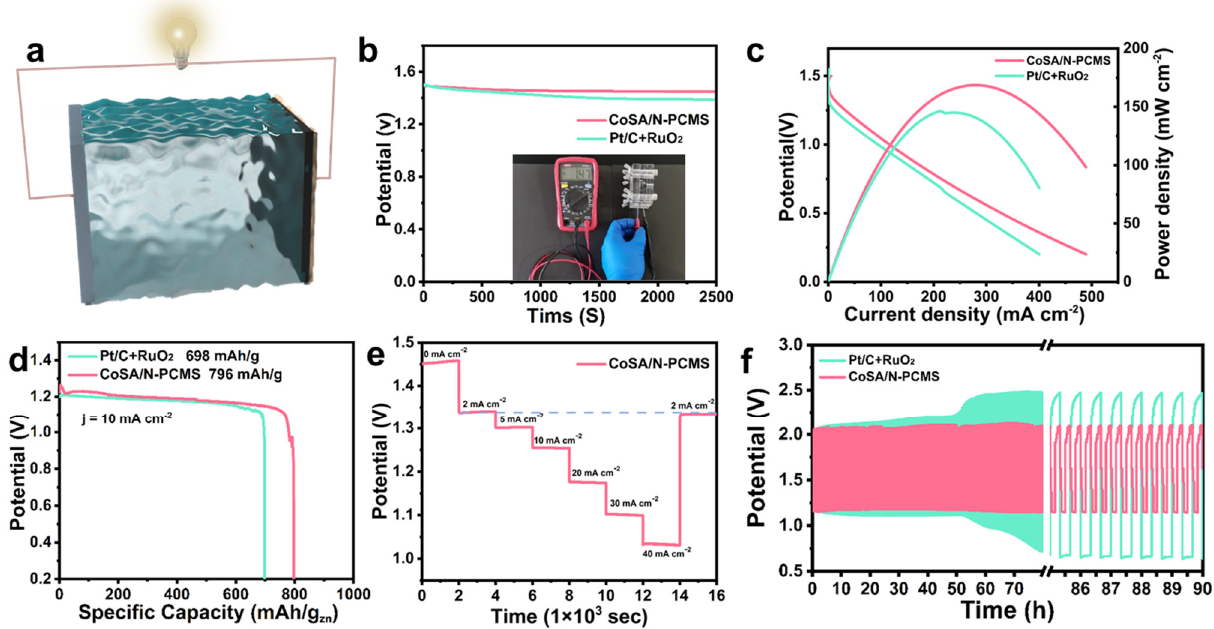
Figure 5. ( a ) Schematic diagram of the aqueous ZAB using CoSA/N − PCMS as an air cathode. ( b ) OpeN − Circuit voltage (OCV) measurements of assembled ZABs with CoSA/N − PCMS and Pt/C+RuO 2 . ( c ) The polarization and power density results for ZABs with CoSA/N − PCMS and Pt/C+RuO 2 . ( d ) The discharge curves of ZABs based on CoSA/N − PCMS and Pt/C+RuO 2 at 10 mA/cm 2 . ( e ) Discharge curves of the ZAB assembled with CoSA/N − PCMS at varied current densities. ( f ) Discharge/charge cycling performance of ZABs based on CoSA/N − PCMS and Pt/C+RuO 2 at 10 mA/cm 2 .